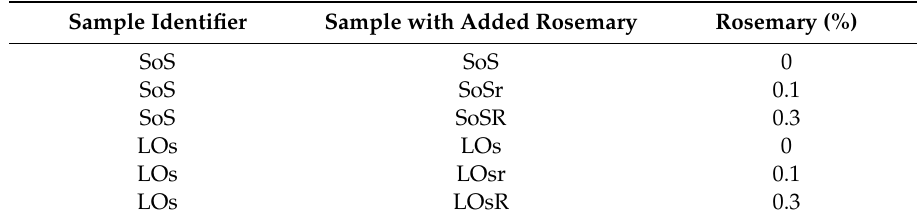
Table 2. Samples with added antioxidant agent. Sample with added rosemary where r = 0.1% and R = 0.3% added rosemary.